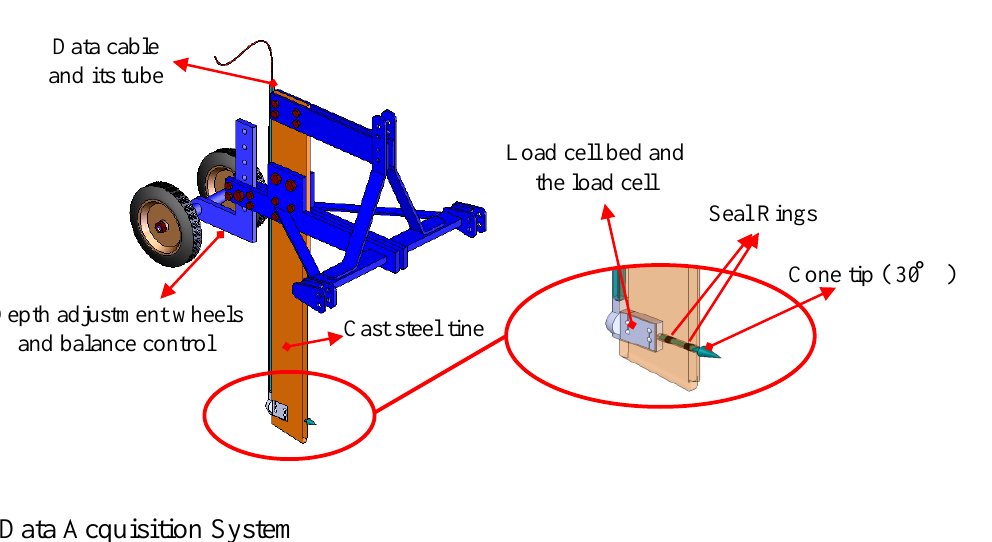
Figure 2. Design of the mechanical